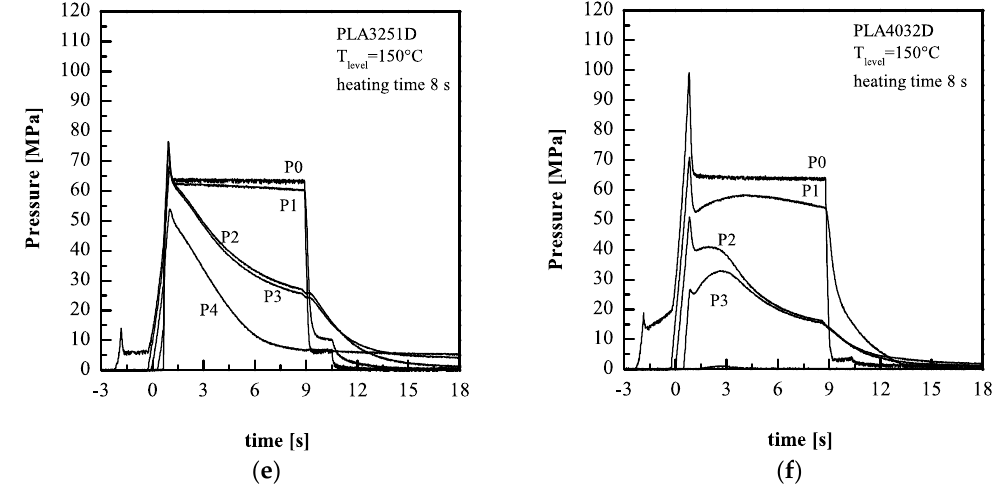
Figure 2. Pressure evolutions in different positions along the flow path recorded during the experiments ( a ) Passive-A, ( b ) Passive-B, ( c ) 100-8-63-A, ( d ) 100-8-63-B, ( e ) 150-8-63-A, and ( f ) 150-8-63-B. In all the figures, t = 0 s corresponds to the time that the melt came in contact with the cavity surface in the position P2.